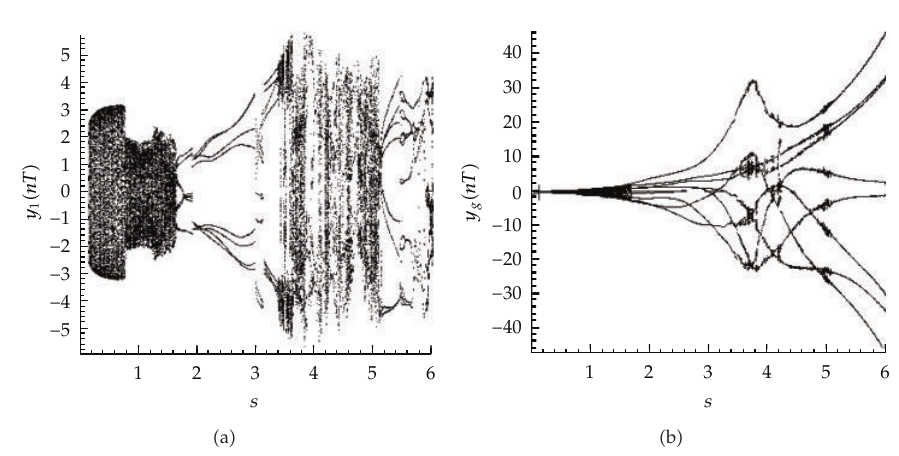
Figure 2: Bifurcation diagrams of gear-bearing system using dimensionless rotational speed ratio, s , as bifurcation parameter for non-Newtonian lubricating fluid with l ∗ (cid:9) 0 . 0.